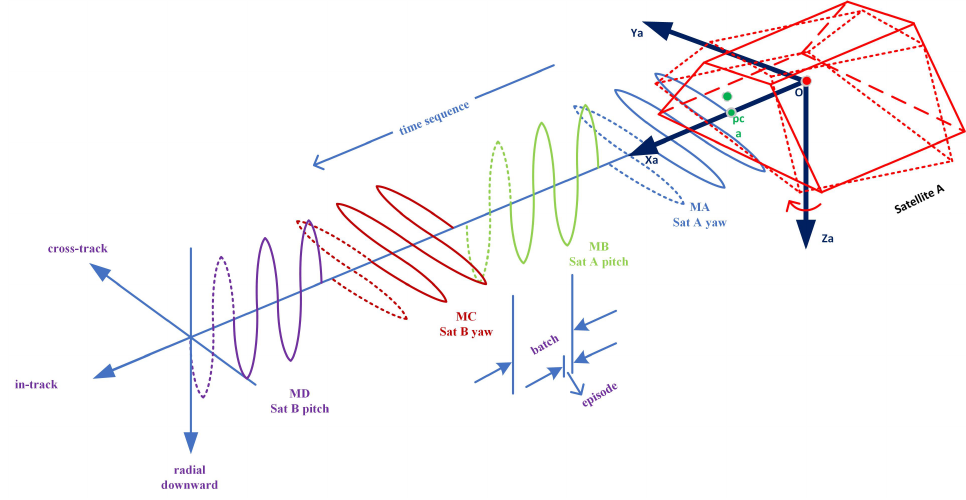
Figure 4. Illustration of training process during sub-maneuvers. (MA means sub-maneuver